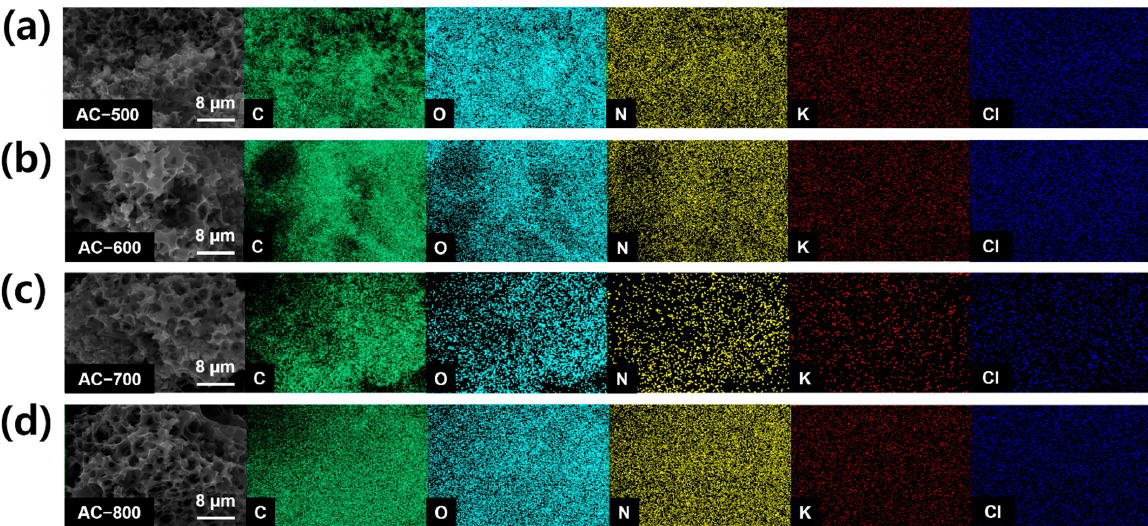
Figure 5. SEM-EDX mapping images of elements such as C, O, N, K, and Cl ( a ) AC-500, ( b ) AC-600, ( c ) AC-700, and ( d ) AC-800.